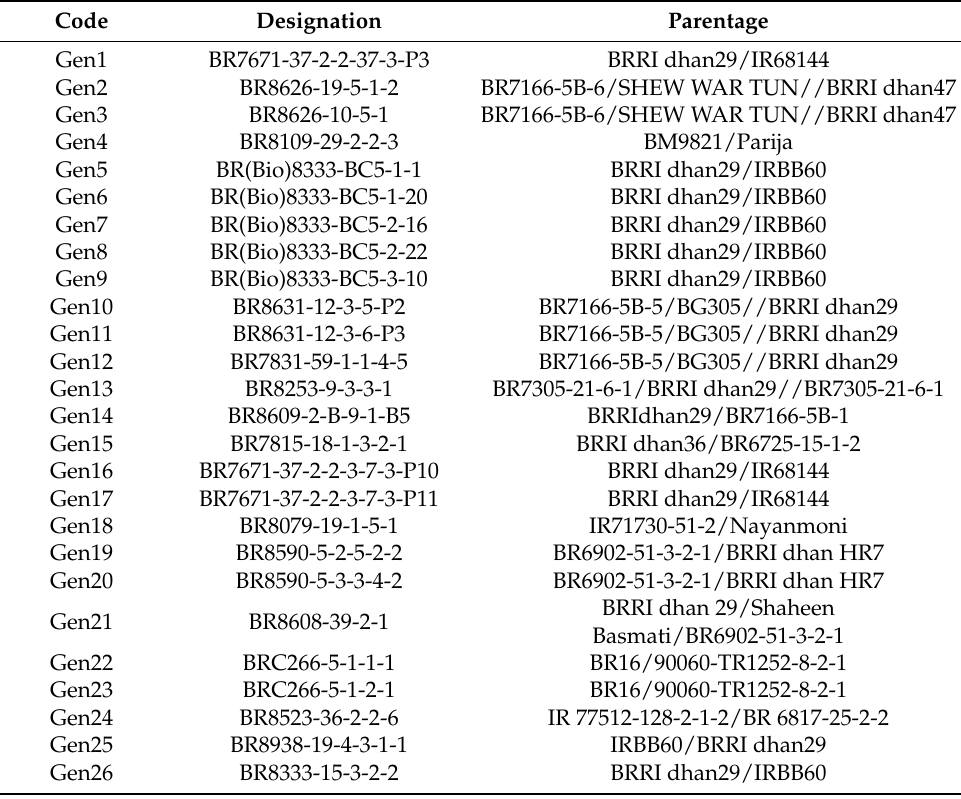
Table 2. The designation and parentages of 34 elite rice cultivars utilized in the current